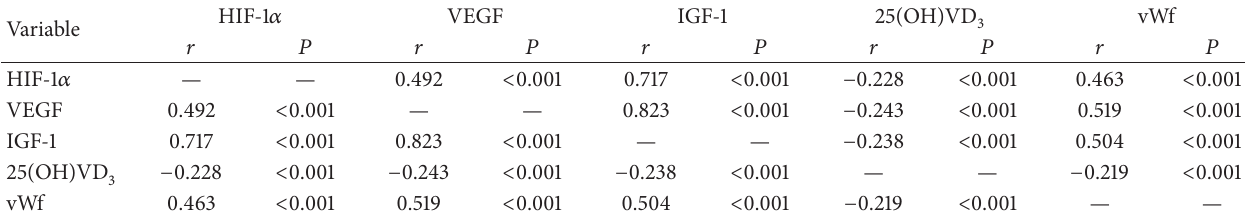
Table 4: Correlation with serum levels of HIF-1 𝛼 , VEGF, vWf, IGF-1, and 25(OH)VD 3 .